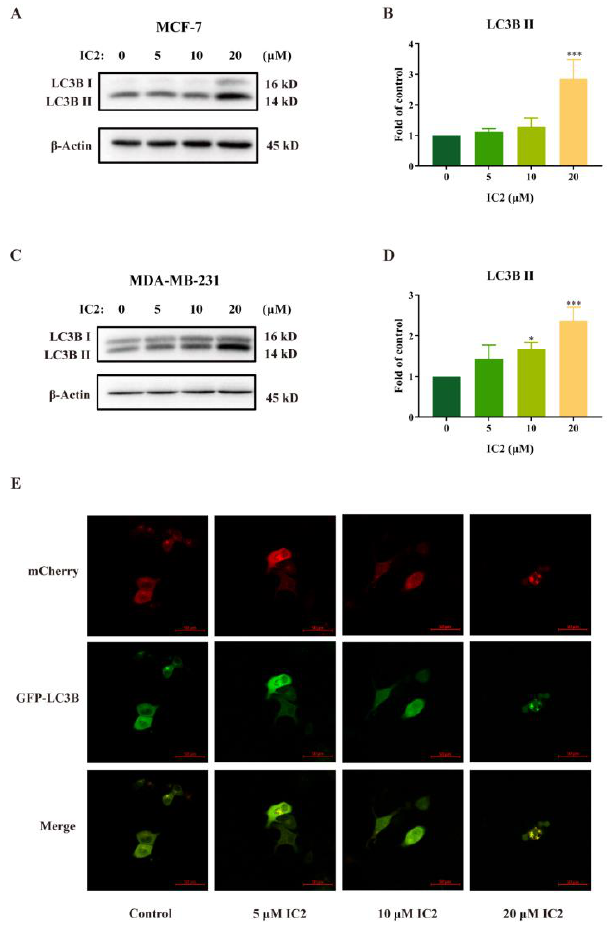
Figure 2. IC2 increases LC3B II expression and GFP-LC3 puncta formation in breast cancer